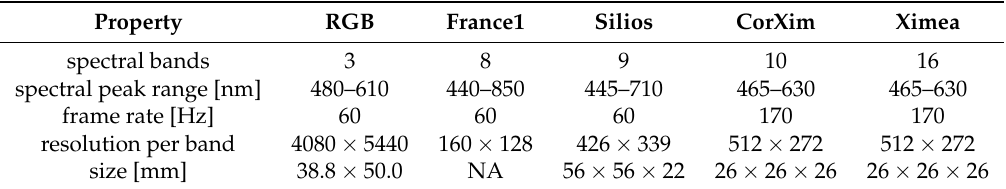
Table 1. Features of the included cameras. RGB camera [60], commercially available XIMEA Xispec device from academia [3]